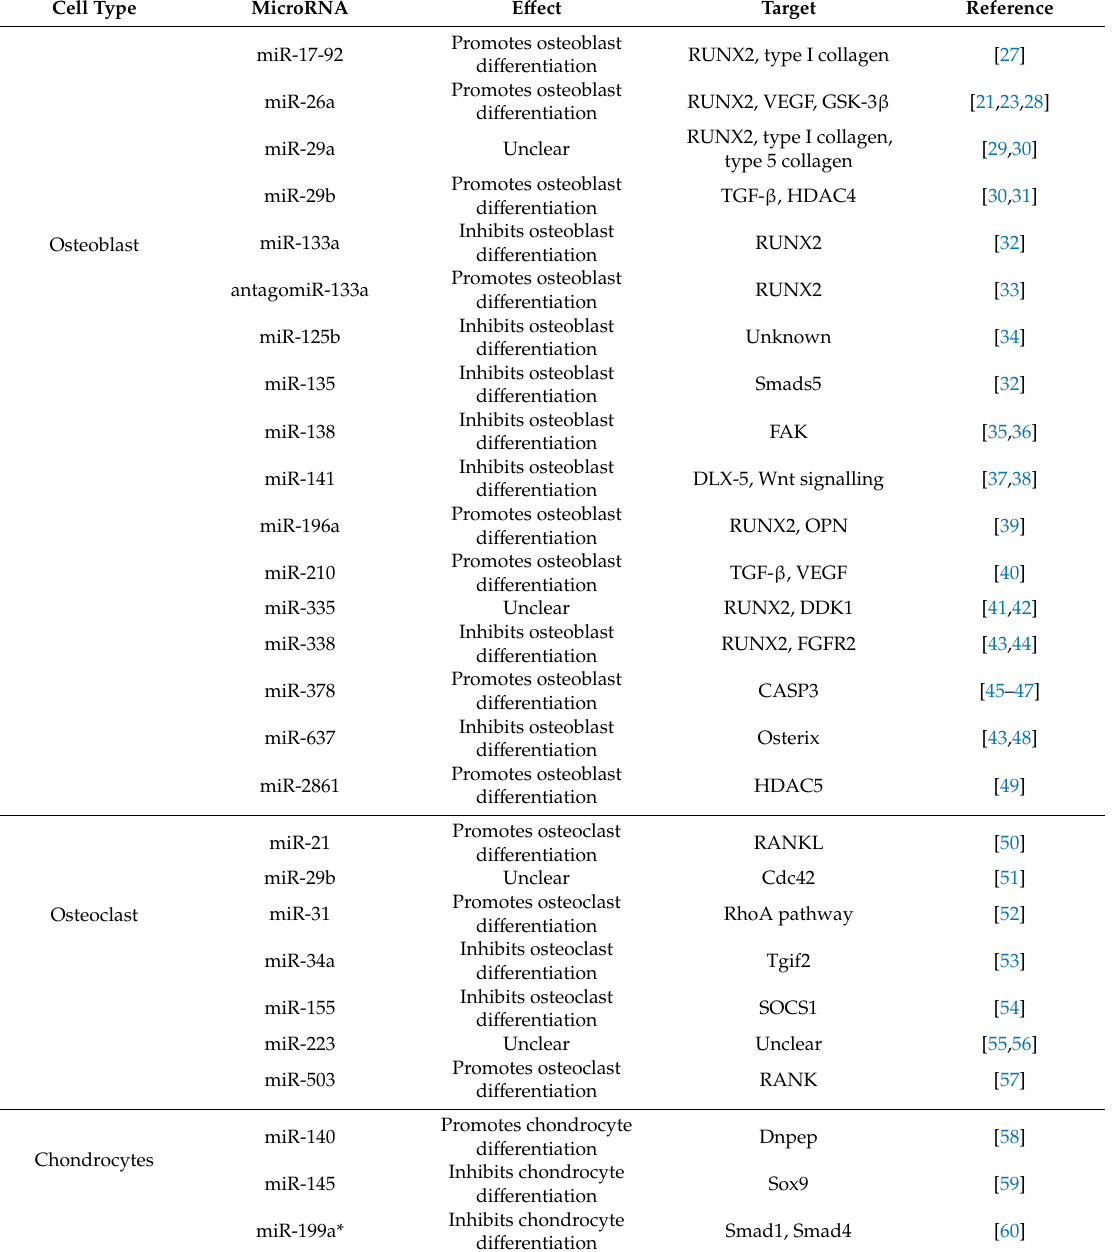
Table 1. MicroRNA for regulation of bone markers and their e ff ect on targeted genes during bone